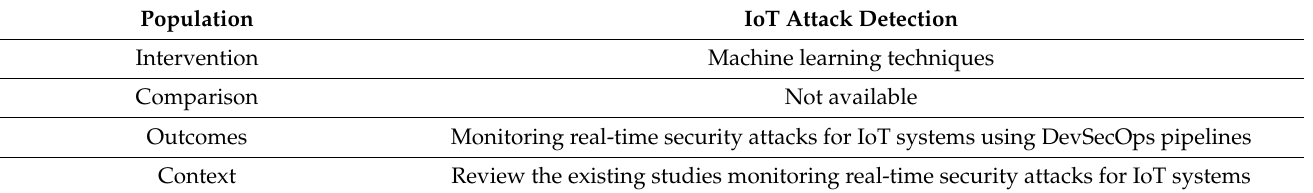
Table 1. Population, Intervention, Comparison, Outcomes, and Context (PICOC) criteria.